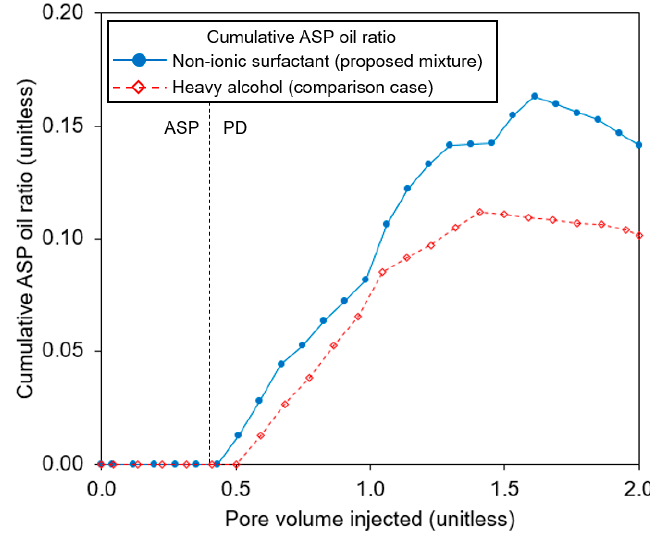
Figure 7. Comparison of cumulative ASP oil ratio (CAOR) to evaluate the efficiency of ASP flooding.